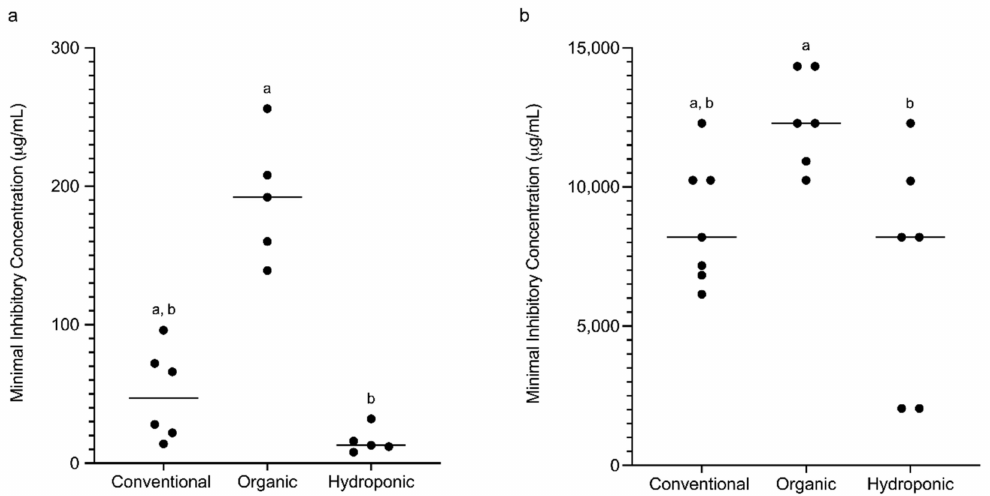
Figure 2. Minimum inhibitory concentration (MIC) of resistant bacteria isolated from lettuce samples: ( a ) tetracycline; ( b ) sulphadiazine. Di ff erent letters indicate a significant di ff erence ( p < 0.05), one-way ANOVA with a Kruskal–Wallis comparison